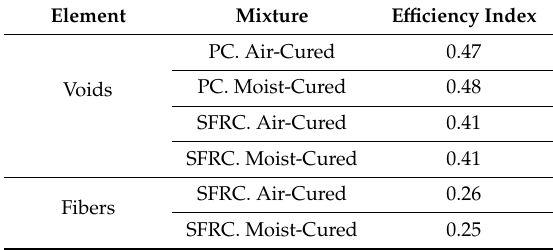
Table 4. E ffi ciency